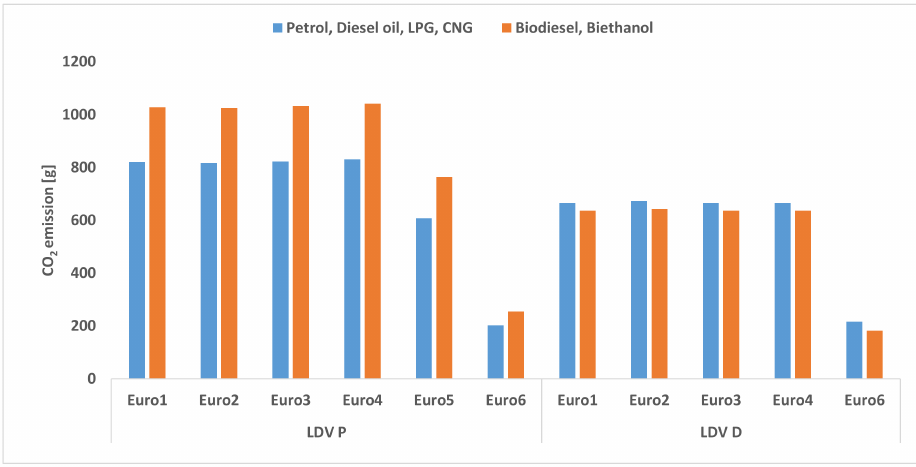
Figure 5. Comparison of CO 2 emissions from LDVs depending on Euro standard and fuel